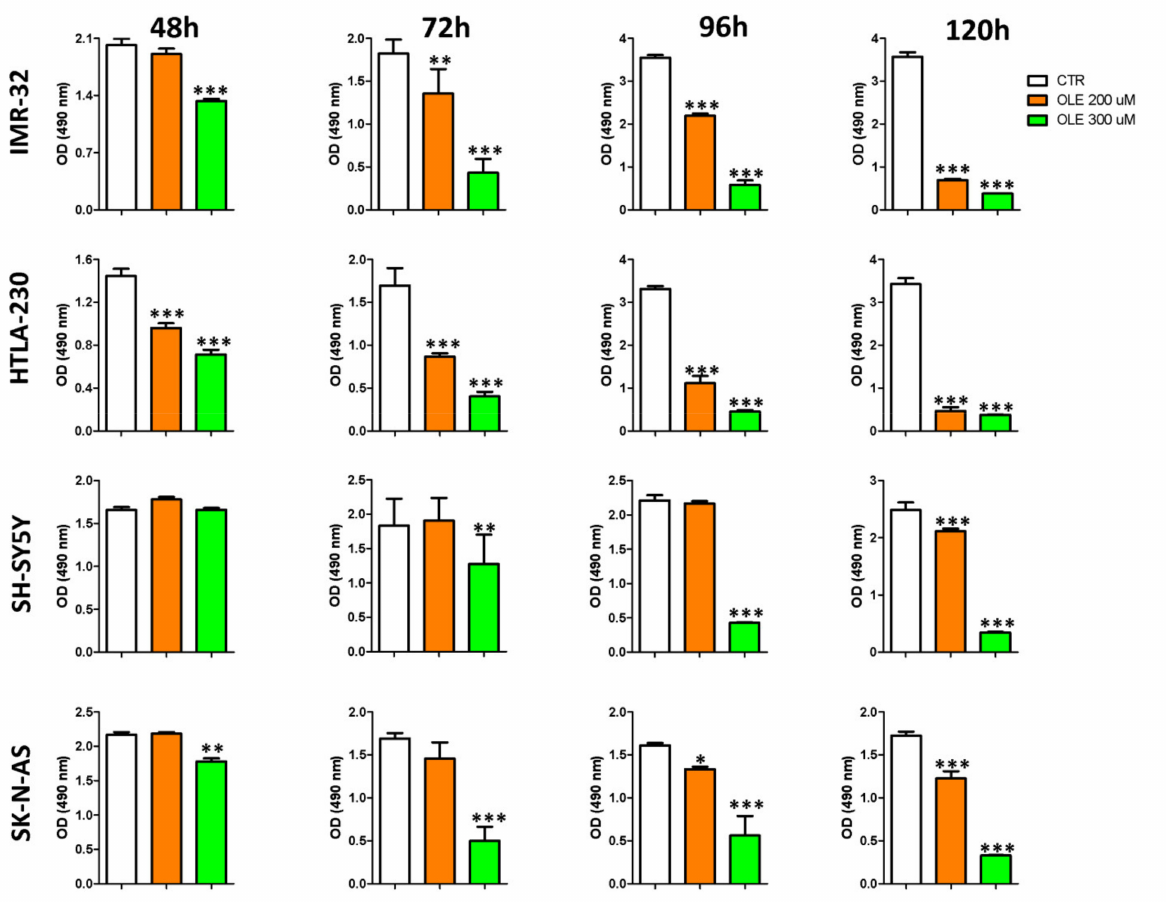
Figure 2. Time-dependent effects of OLE treatment on the cell viability of NB cells. The MTS assay was performed after 48, 72, 96, and 120 h of OLE treatment. Optical density (OD, at 490 nm) was recorded by the use of the TECAN micro-plate reader, Infinite 200 (Tecan Life Sciences). Data are expressed as mean ± SD of three independent experiments (* p < 0.05, ** p < 0.01, *** p < 0.001 vs. CTR). CTR: control; OLE: olive leaf extract; uM: micromolar; h: hours; nm: